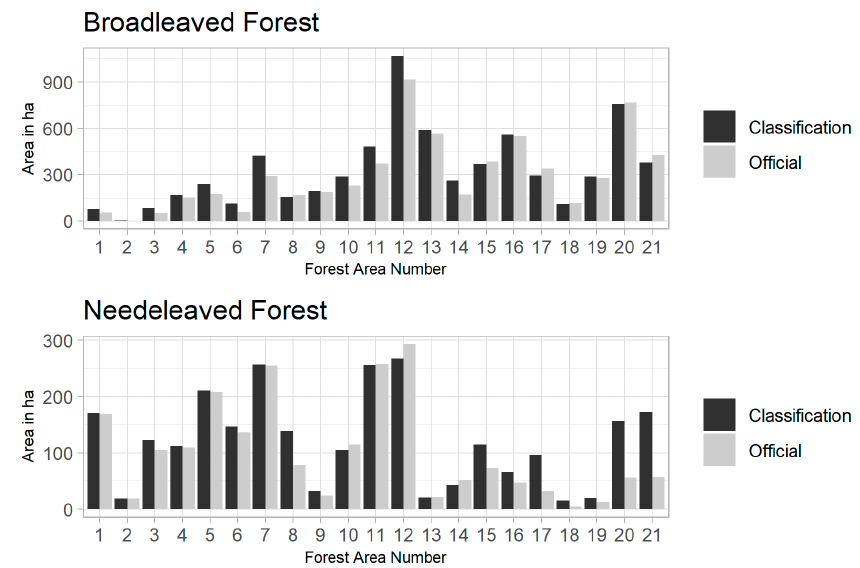
Figure 8. Area comparison of the best performing forest type classification (Segmentation: RGB+nIR; Training: Manual; Input Features: RGB+nIR+texture) with the official carto-/topographic database for each selected forest area.